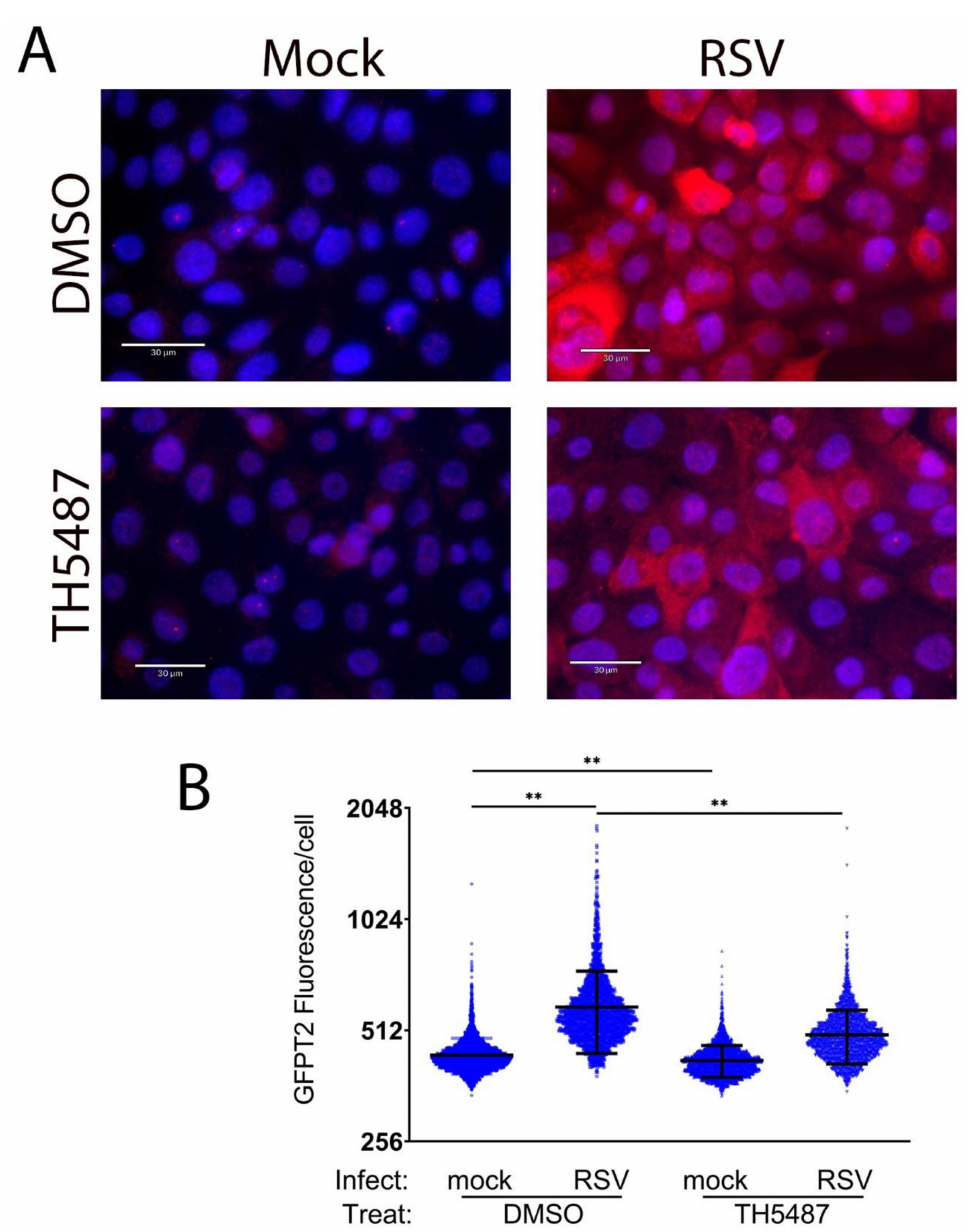
Figure 7. OGG1 is required for RSV-induced GFPT2 expression. ( A ) hSAECs were treated with solvent (DMSO) or TH5487 and mock- or RSV-infected as indicated. Cells were stained with anti- GFPT2 Ab (red) and nuclei by DAPI (blue). Bar indicates 30 µ m. ( B ) The quantitation of GFPT2 staining. GFPT2 fluorescence was segmented by StarDist and plotted as arbitrary fluorescence/cell for each treatment condition. **, p < 0.01 by post-hoc Tukey